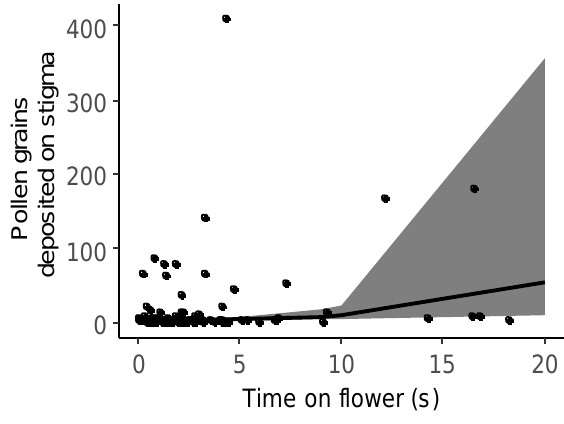
Figure 7. Relationship between the amount of time spent on a canola flower by a pollinator and the number of pollen grains deposited, with predicted trend line plotted against observed (non-adjusted) points. Shaded area represents 95%